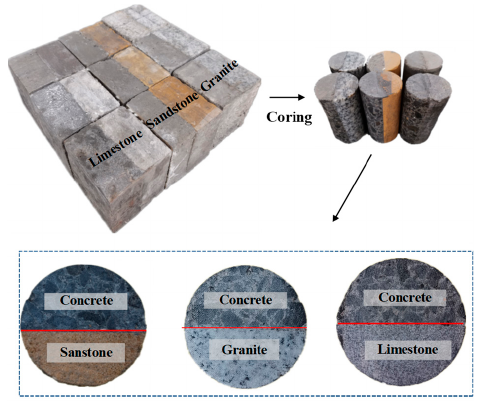
Figure 1. Preparation of concrete–rock mixed